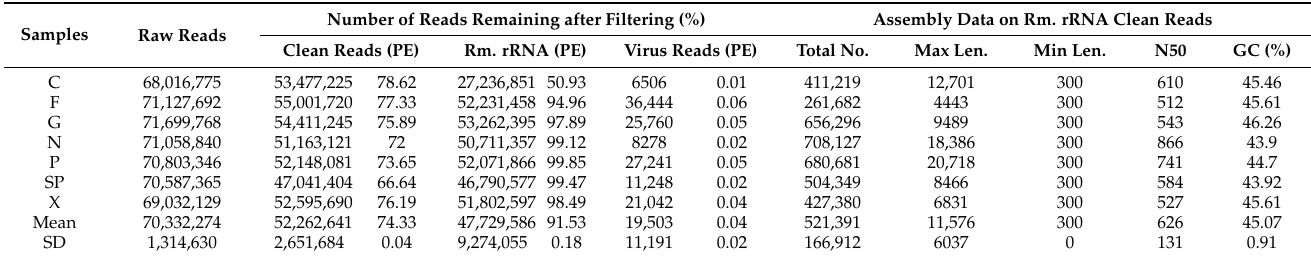
Table 1. Overview of reads and contigs sequences of various tissues from